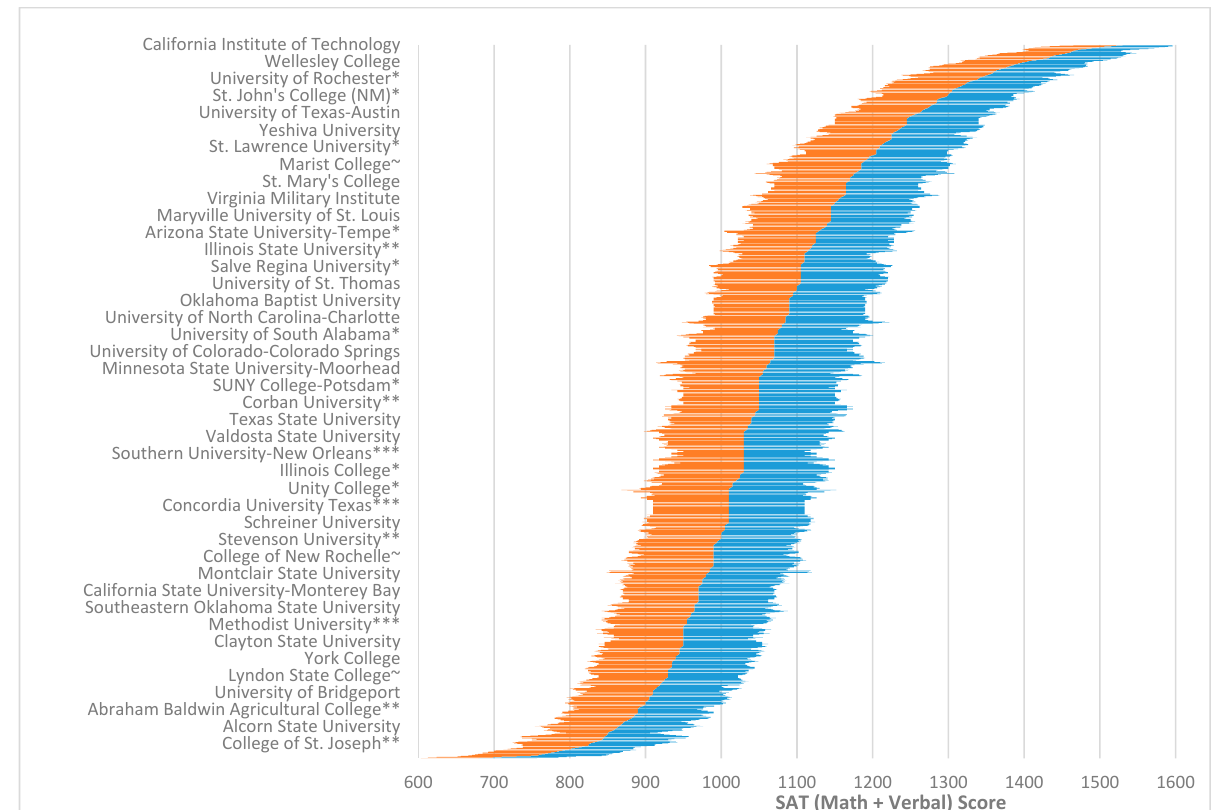
Figure 1. Overall distribution of 25th to 75th SAT (Math + Verbal) percentile scores for colleges and universities included in this study (for a full list see Supplementary A). 25th percentile scores for an institution are indicated by the far left point of the left region ( orange ) of the graph, whereas 75th percentile scores are indicated by the far right point of the right region ( blue ). The dividing line between the two sides is roughly the 50th percentile (the average between the 25th and 75th percentile scores). Selected school names are highlighted along the y-axis for ease of reading. The full list of schools used to create Figure 1 can be found in Supplementary A. * At least some students were not required to supply scores to the school; ** The school did not report all students it had scores for, or did not tell U.S. News if it had; *** The data was reported to U.S. News from a previous year; ~ The school may not require scores from all applicants and may not have submitted data for all students.